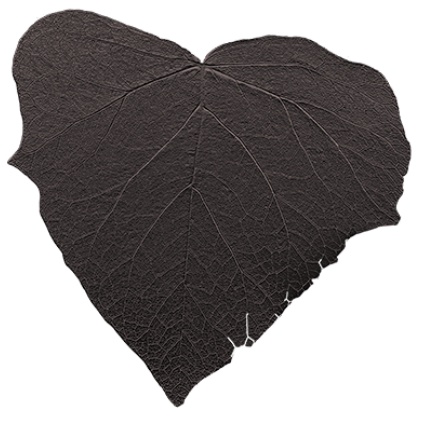
Figure 7. Vector mesh